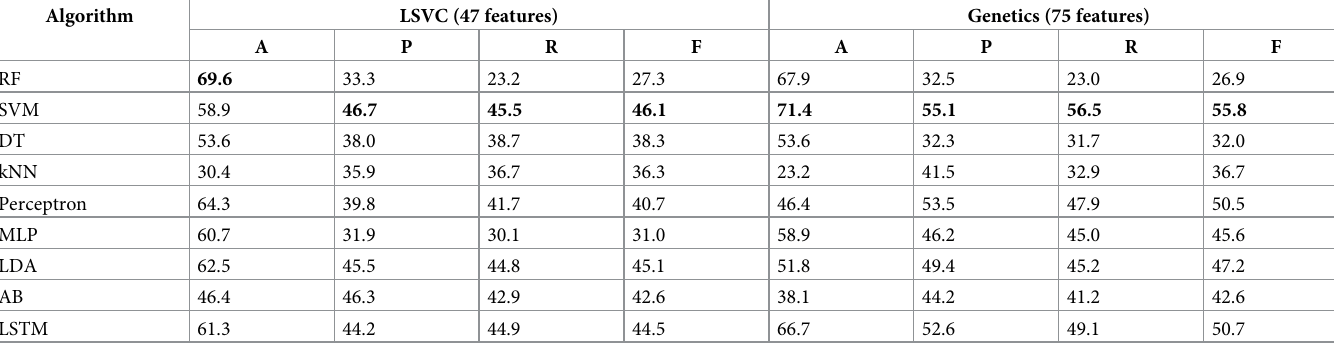
Table 3. Comparison of the performances of LSVC and the genetics algorithm on the augmented dataset (no. class = 3).